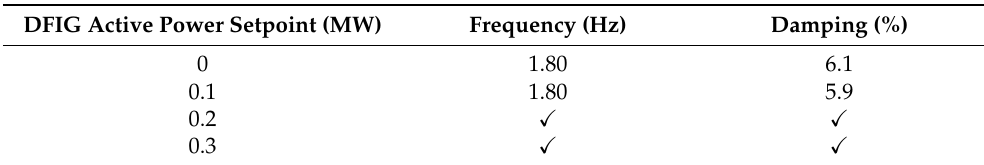
Table 11. Effect of the DFIG active power production on mode D1. Check marks indicate those modes with a damping factor greater than 10%. DFIG Active Power Setpoint (MW)